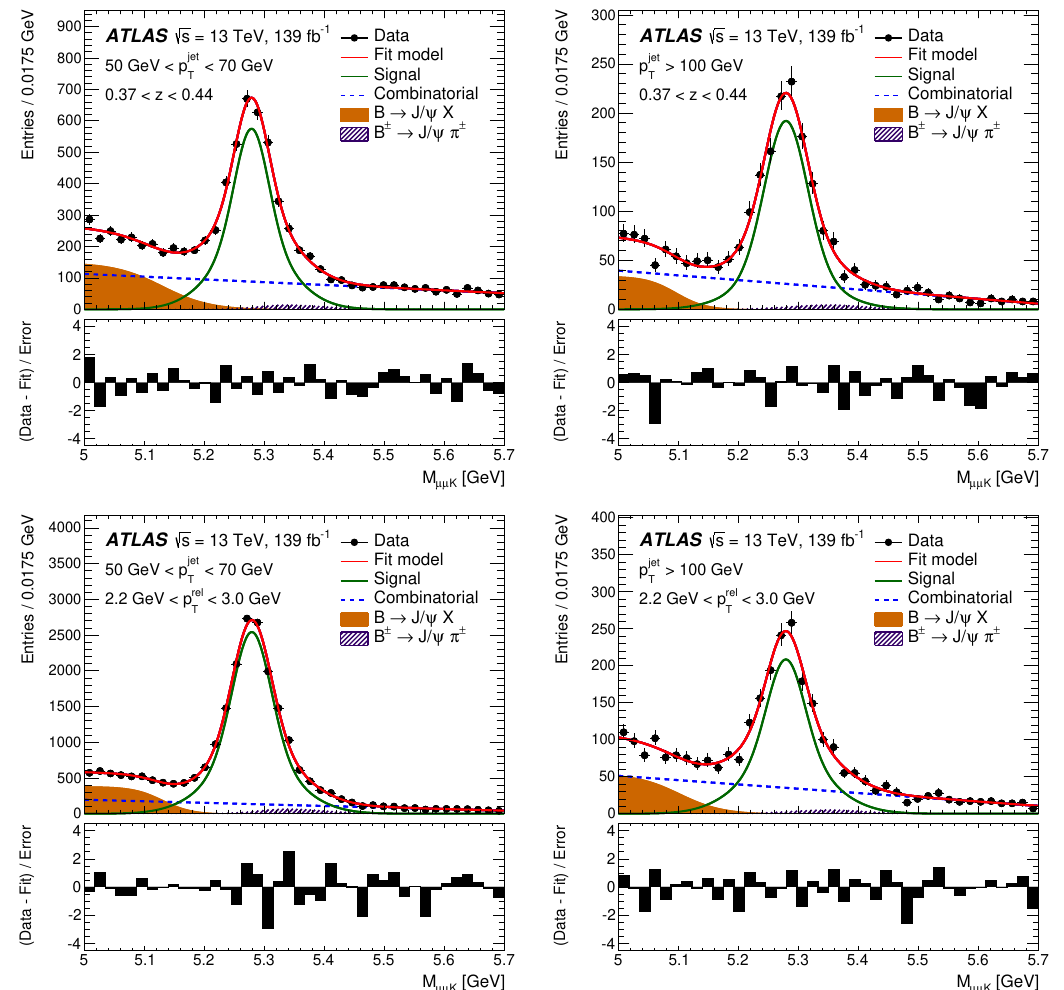
Figure 2 . Fits to the invariant mass distributions of B ± candidates for 0 . 37 < z < 0 . 44 in the lowest and highest jet- p bins (top) and 2 . 2 GeV < p rel < 3 . 0 GeV in the lowest and highest jet- p T T T bins (bottom). The bottom panels show the difference between the data and the fit, divided by the statistical uncertainty of the